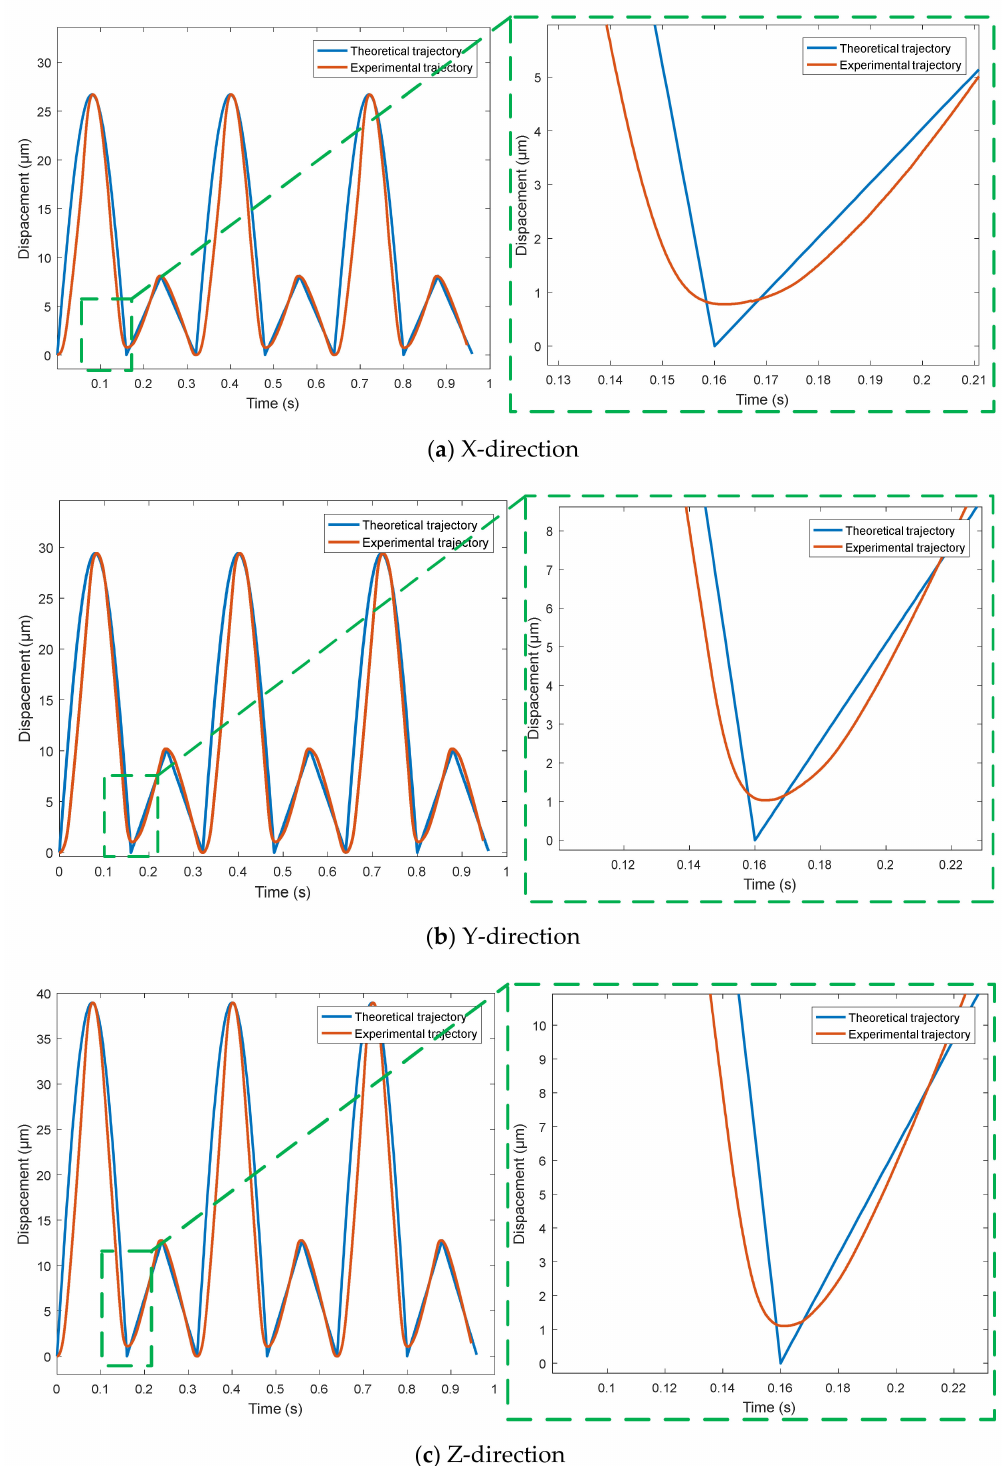
Figure 11. Trajectory tracking performance of complex